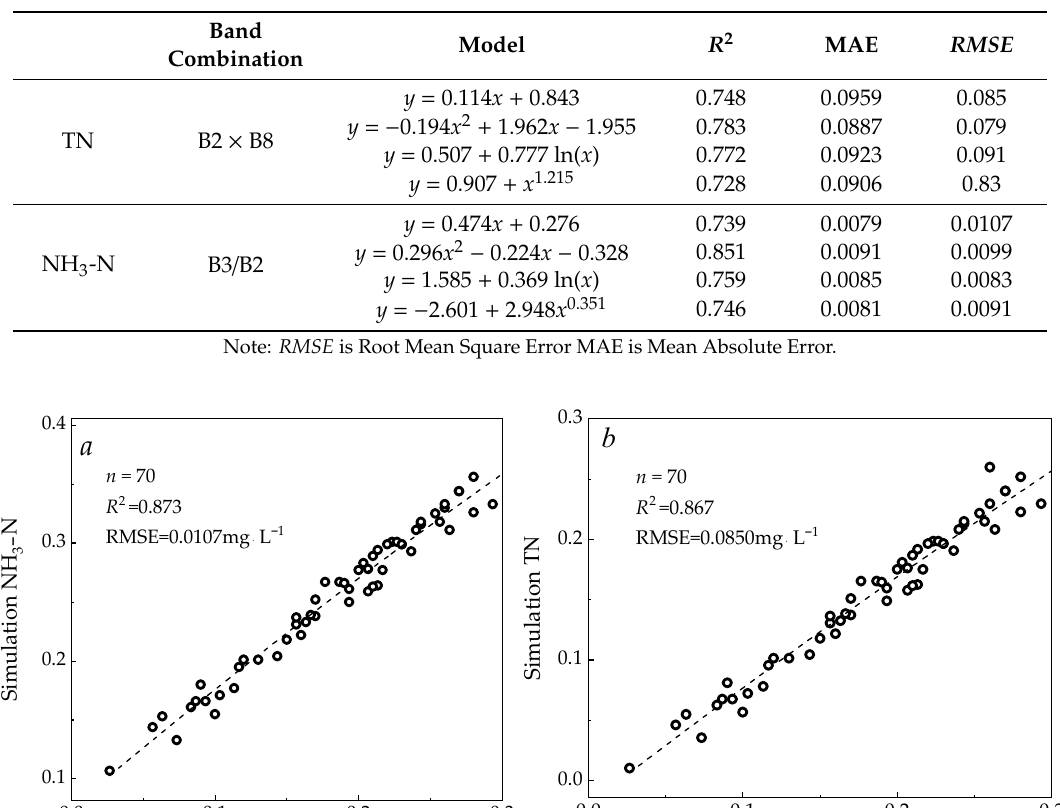
Table 2. The relationship between the band combination and the concentration of TN and NH 3 -N.